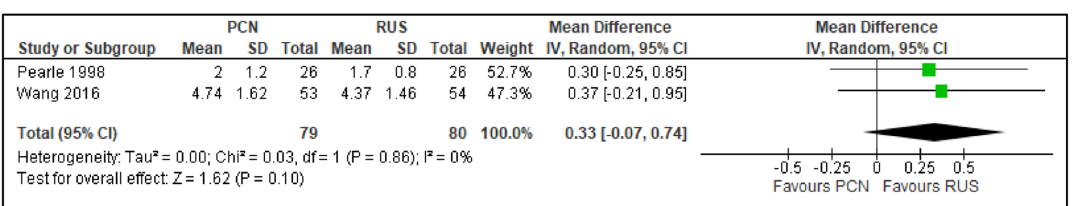
Figure 4. Comparison between PCN and RUS for outcome duration to WBC